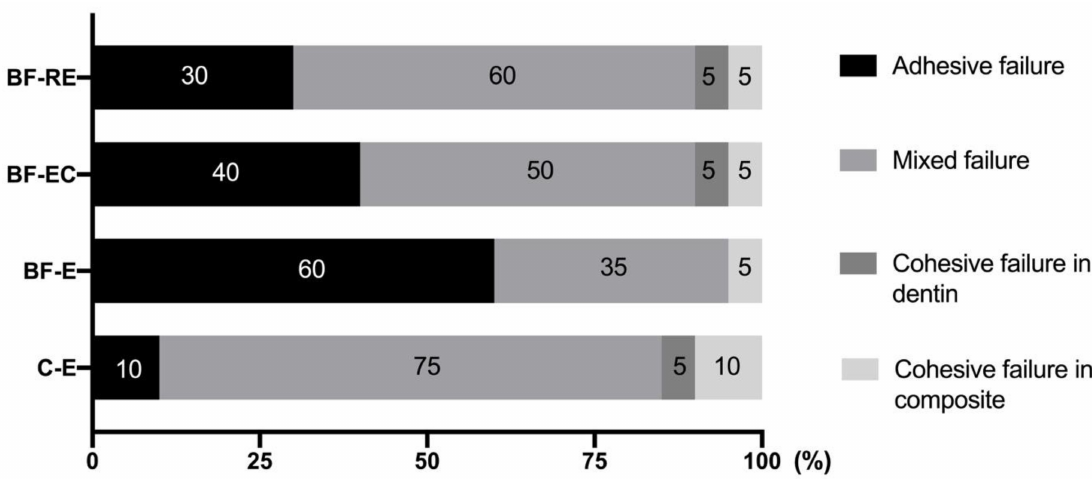
Figure 4. Failure mode analysis of the di ff erent experimental groups (C-E: no biofilm formation and treatment with acid etching, BF-E: biofilm formation and treatment with acid etching, BF-EC: biofilm formation and treatment with acid etching and chlorhexidine, and BF-RE: biofilm formation and treatment with prophylaxis with pumice and acid etching). Numbers within each bar indicate the percentage of the corresponding failure